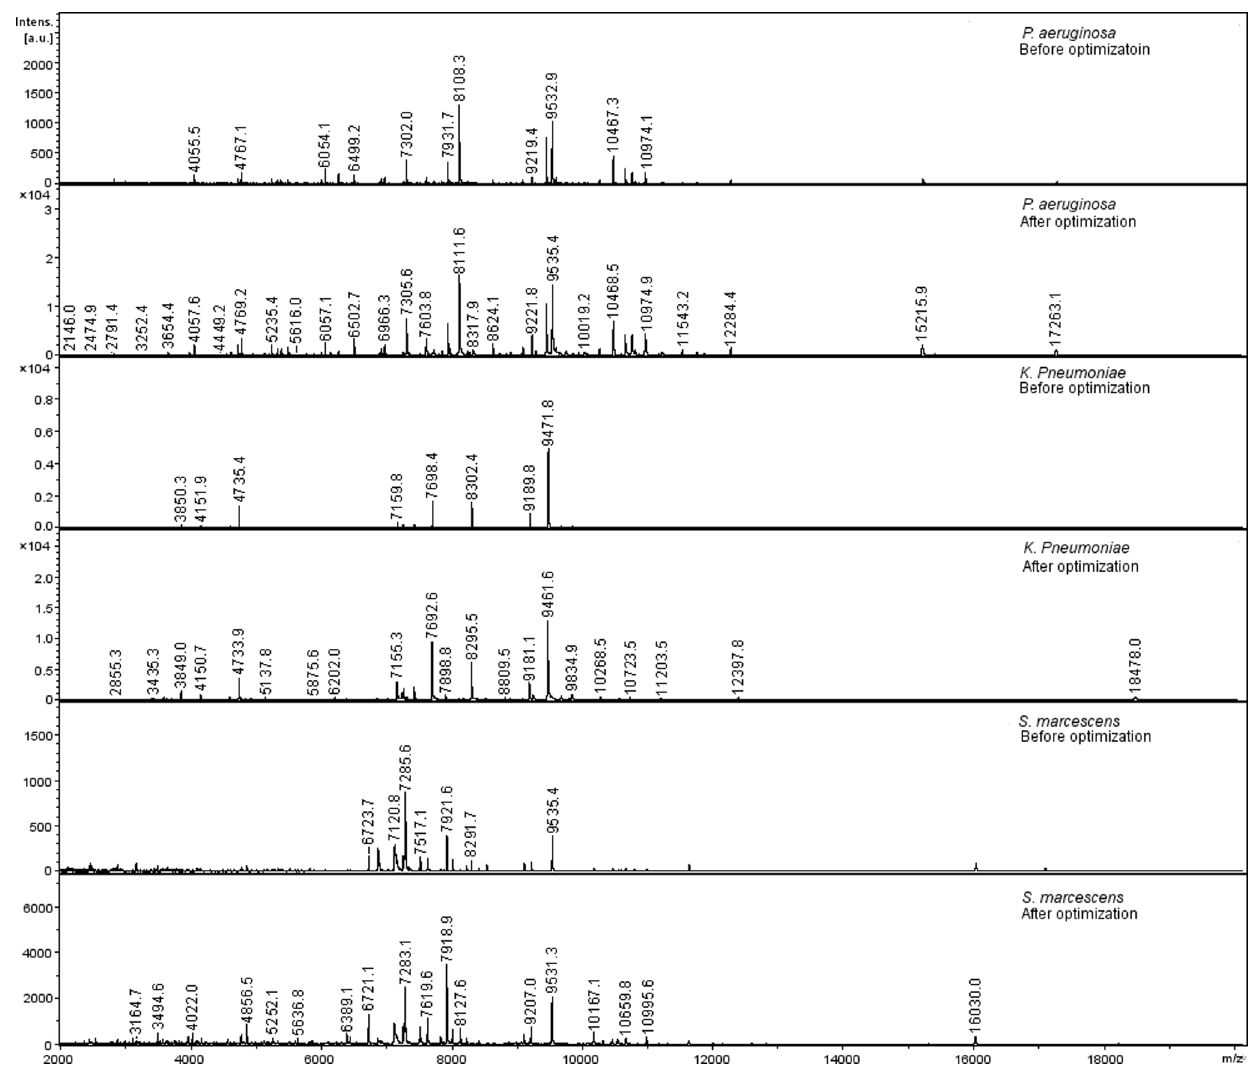
Figure 4. Representative mass spectra acquired via non-optimized and optimized automation settings. Mass spectra of P. aeruginosa , K. pneumoniae and S. marcescens were acquired via non-optimized and optimized settings using automated data acquisition with MALDI-TOF MS. variance results are displayed in Table 3. Factors and interactions that had a p-value less than 0.05 were considered significant. Based on the p-values, threshold peak resolution (D) (p- were found to be significant. The main effects are shown in Figure 2. The mean value of reproducibility obtained with the high level of threshold resolution decreased in comparison with that obtained with the low level of threshold resolution (Fig. 2A). It is also illustrated in Figure 2 that the effect of number of shots on reproducibility shows a positive trend, in which spectrum reproducibility increased with the number of shots summed (Fig. 2B).